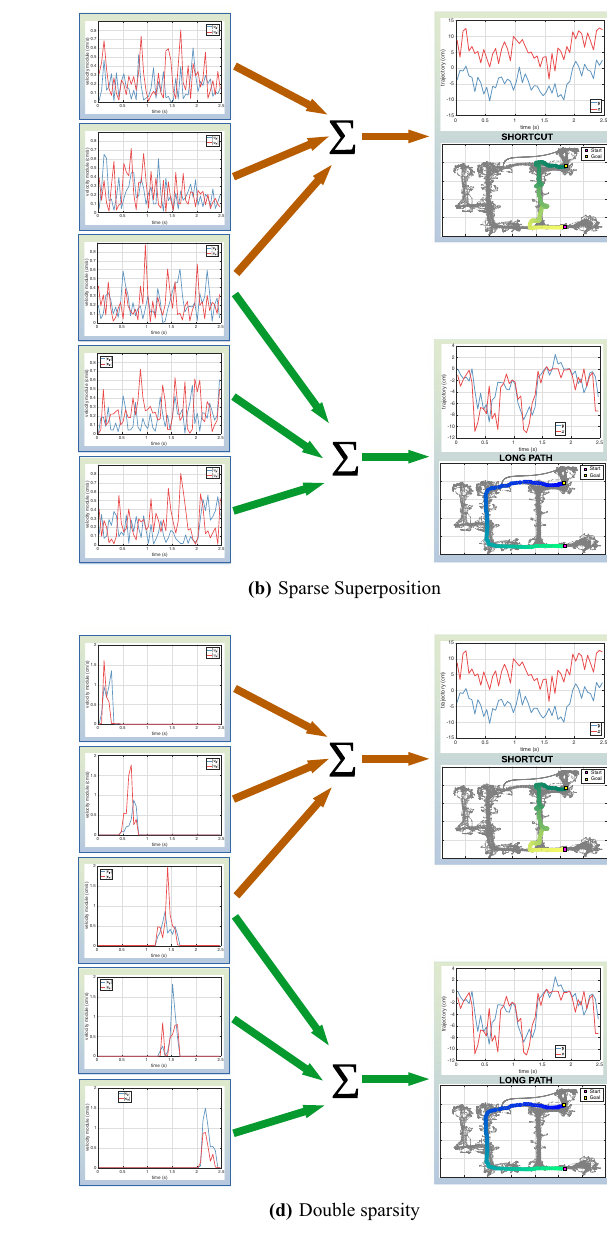
Figure 2. Four alternative approaches and hypotheses on the organization of motor primitives. Panel ( a ) illustrates the hypothesis of no sparsity in motor primitives organization, implemented using Principal Component Analysis (PCA). Panel ( b ) illustrates the sparse superposition hypothesis, implemented using ℓ 1 -regularization. In this perspective, different actions are represented by a combination of small subsets of primitives, which can overlap. The Figure shows an example with five motor primitives, where the first three are jointly used to represent one motor action, and the last three are jointly used to represent another motor action. Panel ( c ) illustrates the sparse activity hypothesis, implemented using SSPCA. In this perspective, actions are represented using all available motor primitives, but these are active only in a restricted time interval, rather than for the entire duration of the action. The Figure shows an example with five motor primitives, all of which are used to represent both motor actions, but are time-localized. Panel ( d ) illustrates the double sparsity hypothesis, which combines the previous two hypotheses and is implemented using SRSSD. See the main text for